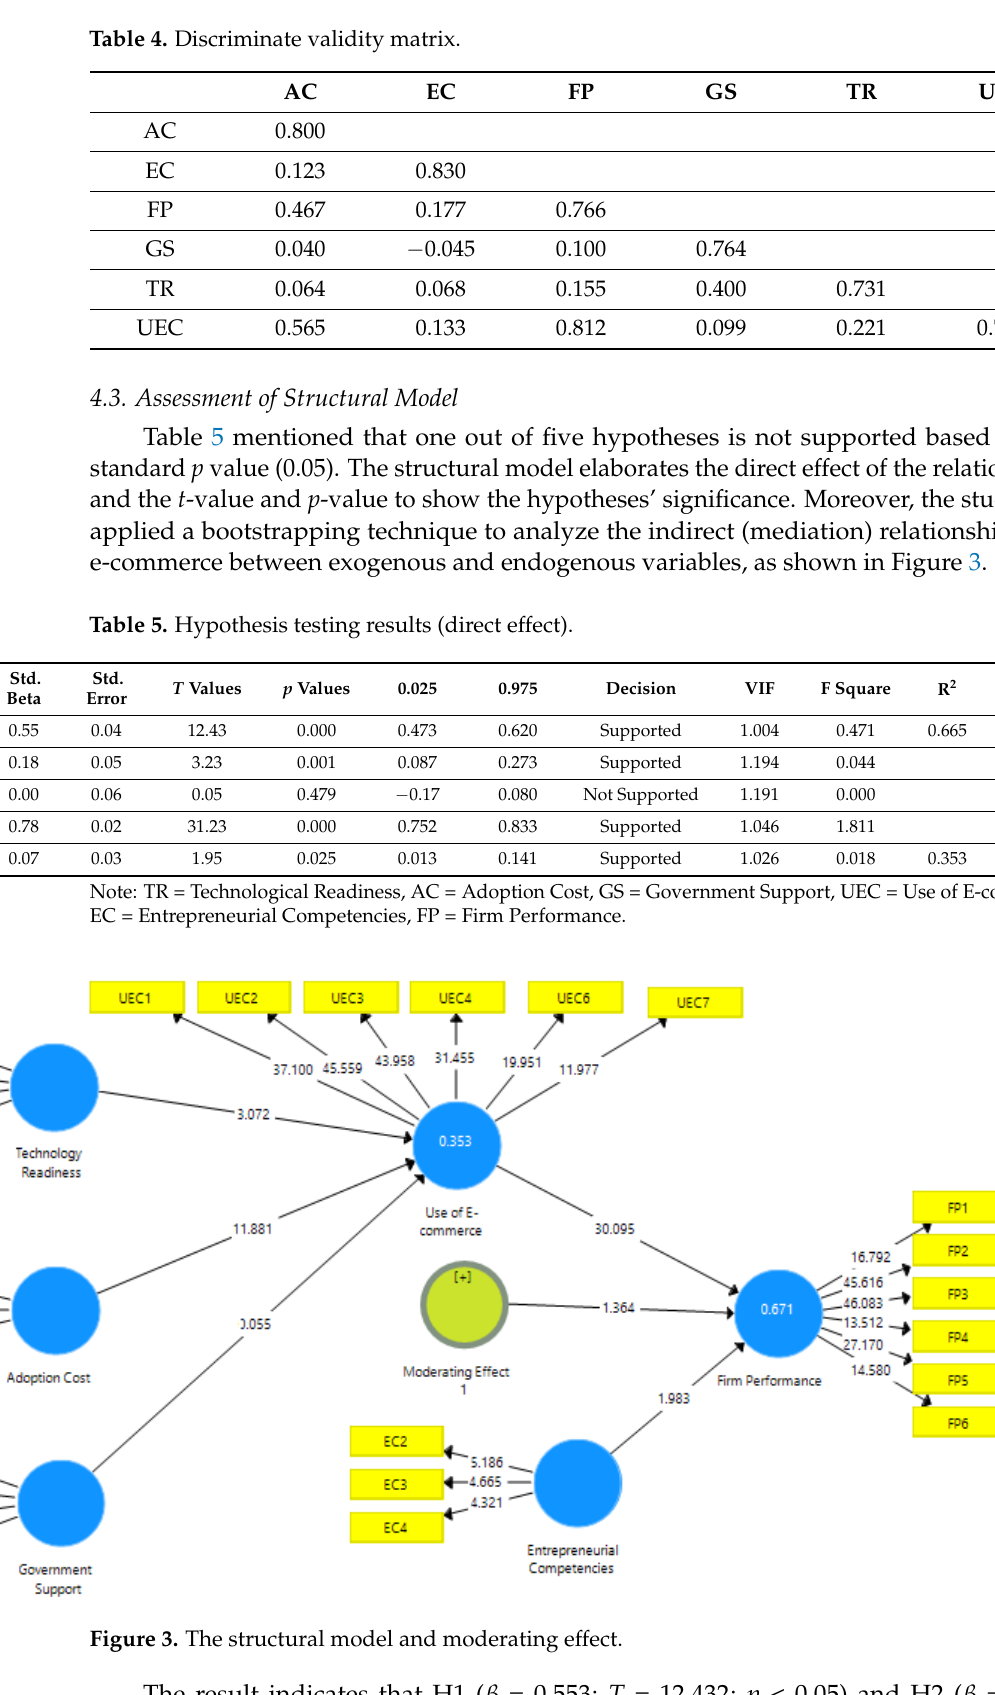
Table 4. Discriminate validity matrix.